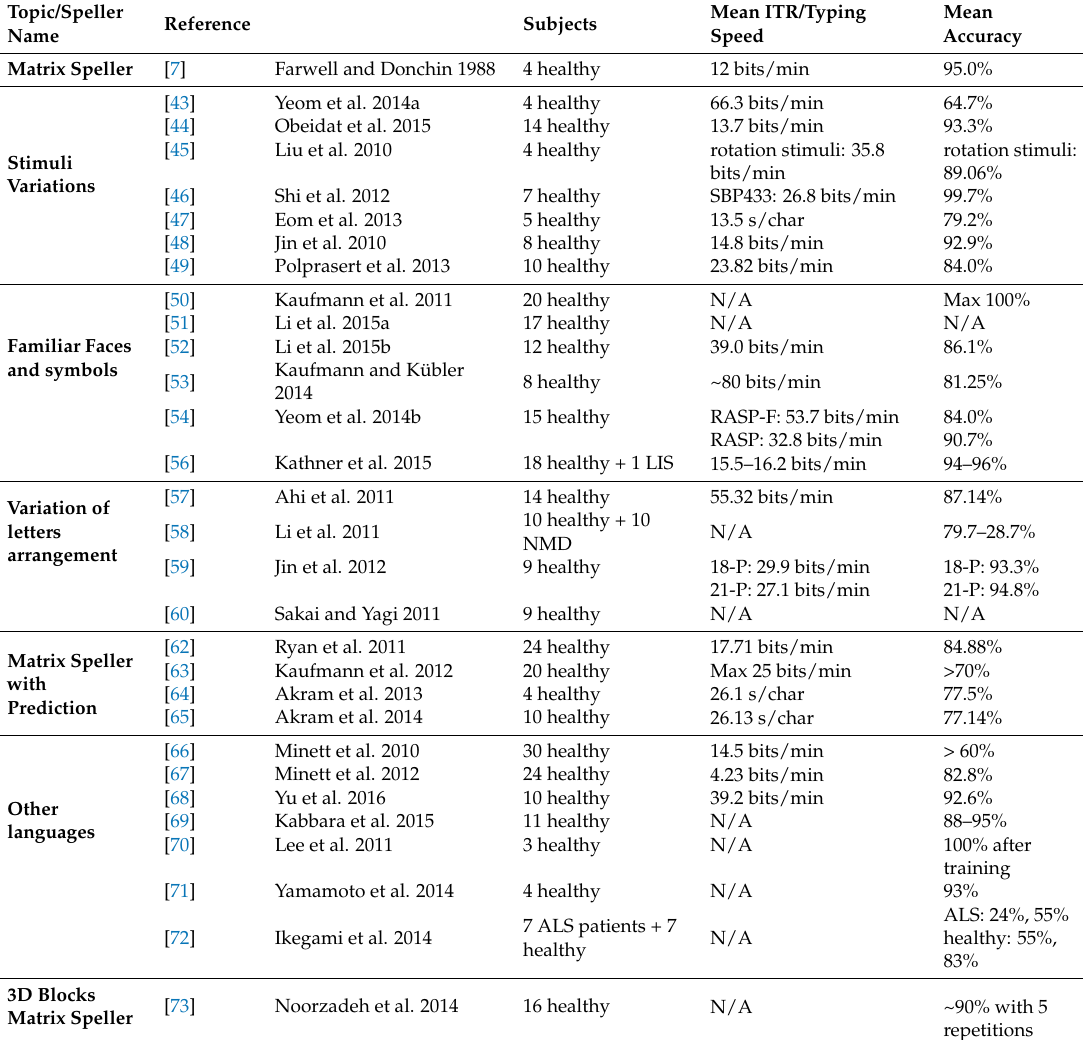
Table 2. Summary of all spellers discussed in this review which are based on the P300 Matrix